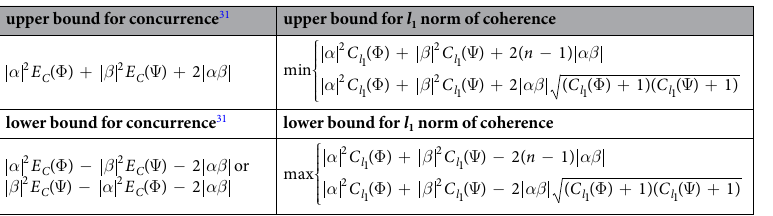
Table 2. Comparison between bounds on concurrence and l 1 norm coherence for the superposition of two orthogonal states (Here E C is concurrence which is a measure of entanglement 31, 38